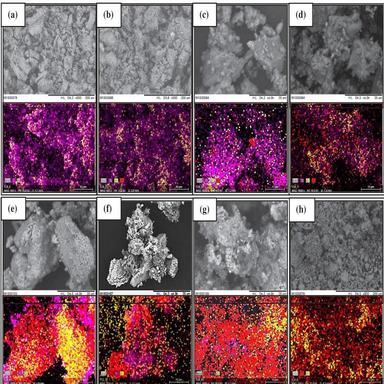
BSE/mapping images for the powdered materials: (a) TC0; (b) TC1; (c) TC2; (d) TC3; (e) TC4; (f) TC5; (fg) TC6; (h) TC7.